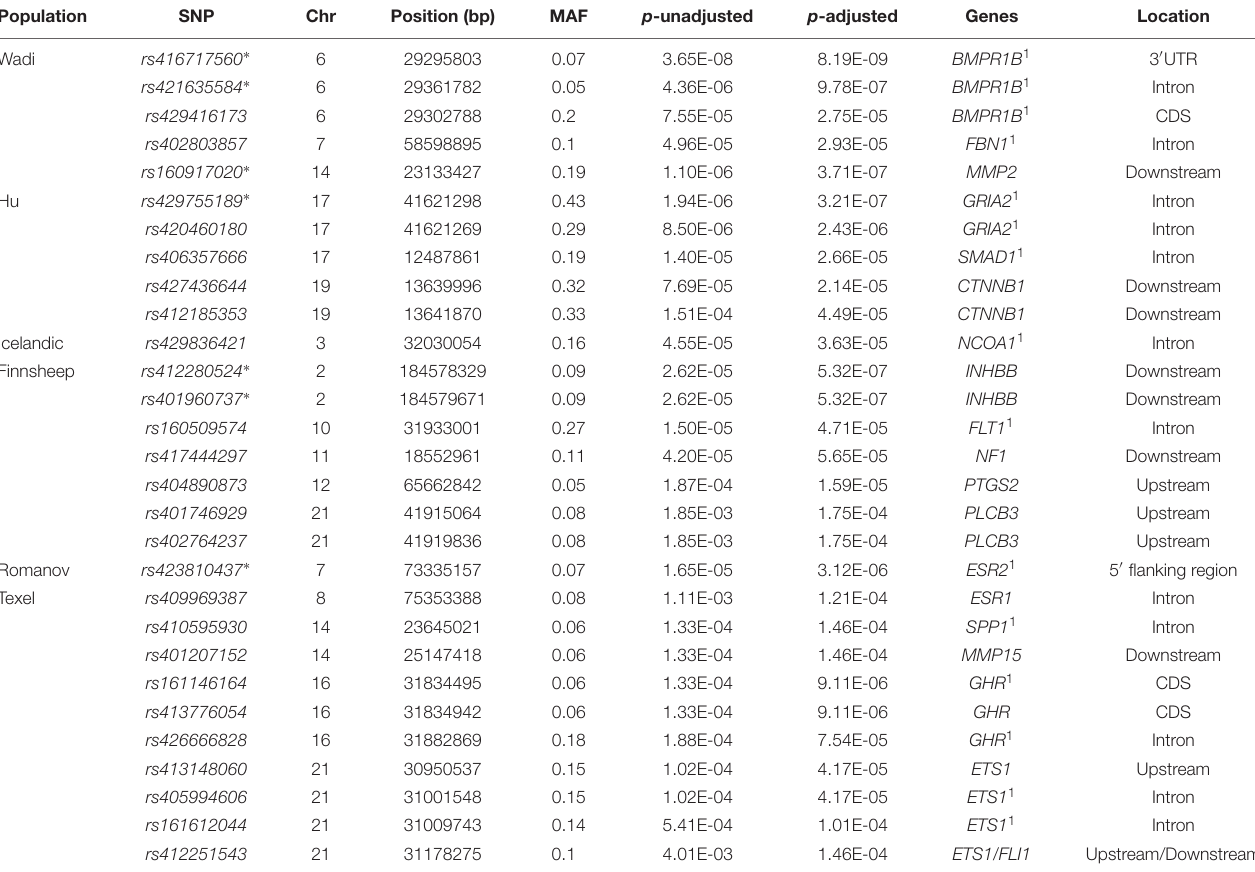
TABLE 2 | Genome-wide and chromosome-wise significant SNPs and associated genes.